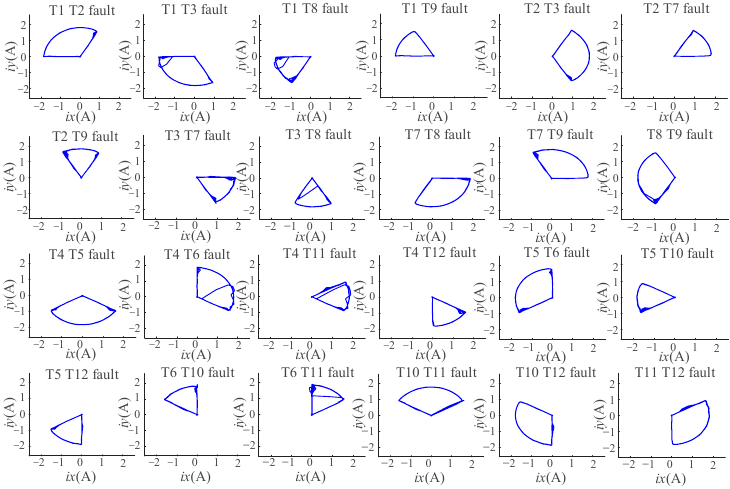
Figure 18. z 1 -z 2 harmonic plane current trace in case of two-switch fault. Figure 18. z 1 - z 2 harmonic plane current trace in case of two-switch